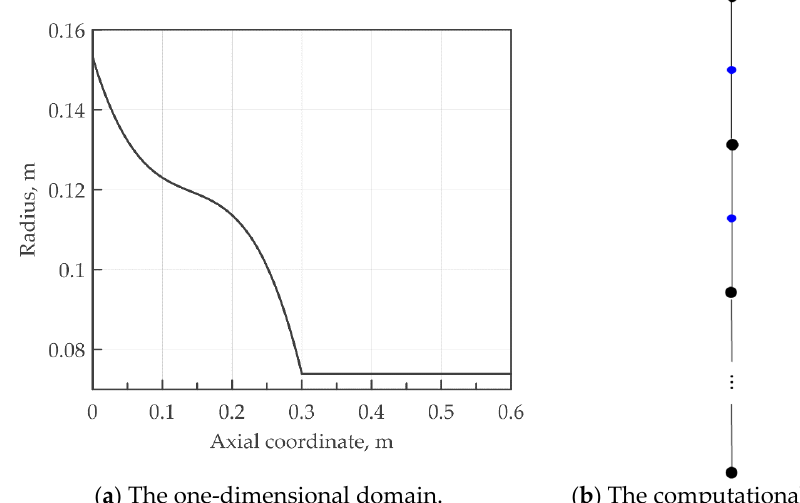
Figure 4. A representation of the computational domain. The motor head is placed at 0.6 m, while the outflow at 0 m ( a ): and the one-dimensional domain. Blue dots represent the cells, while black dots represent the nodes ( b ).